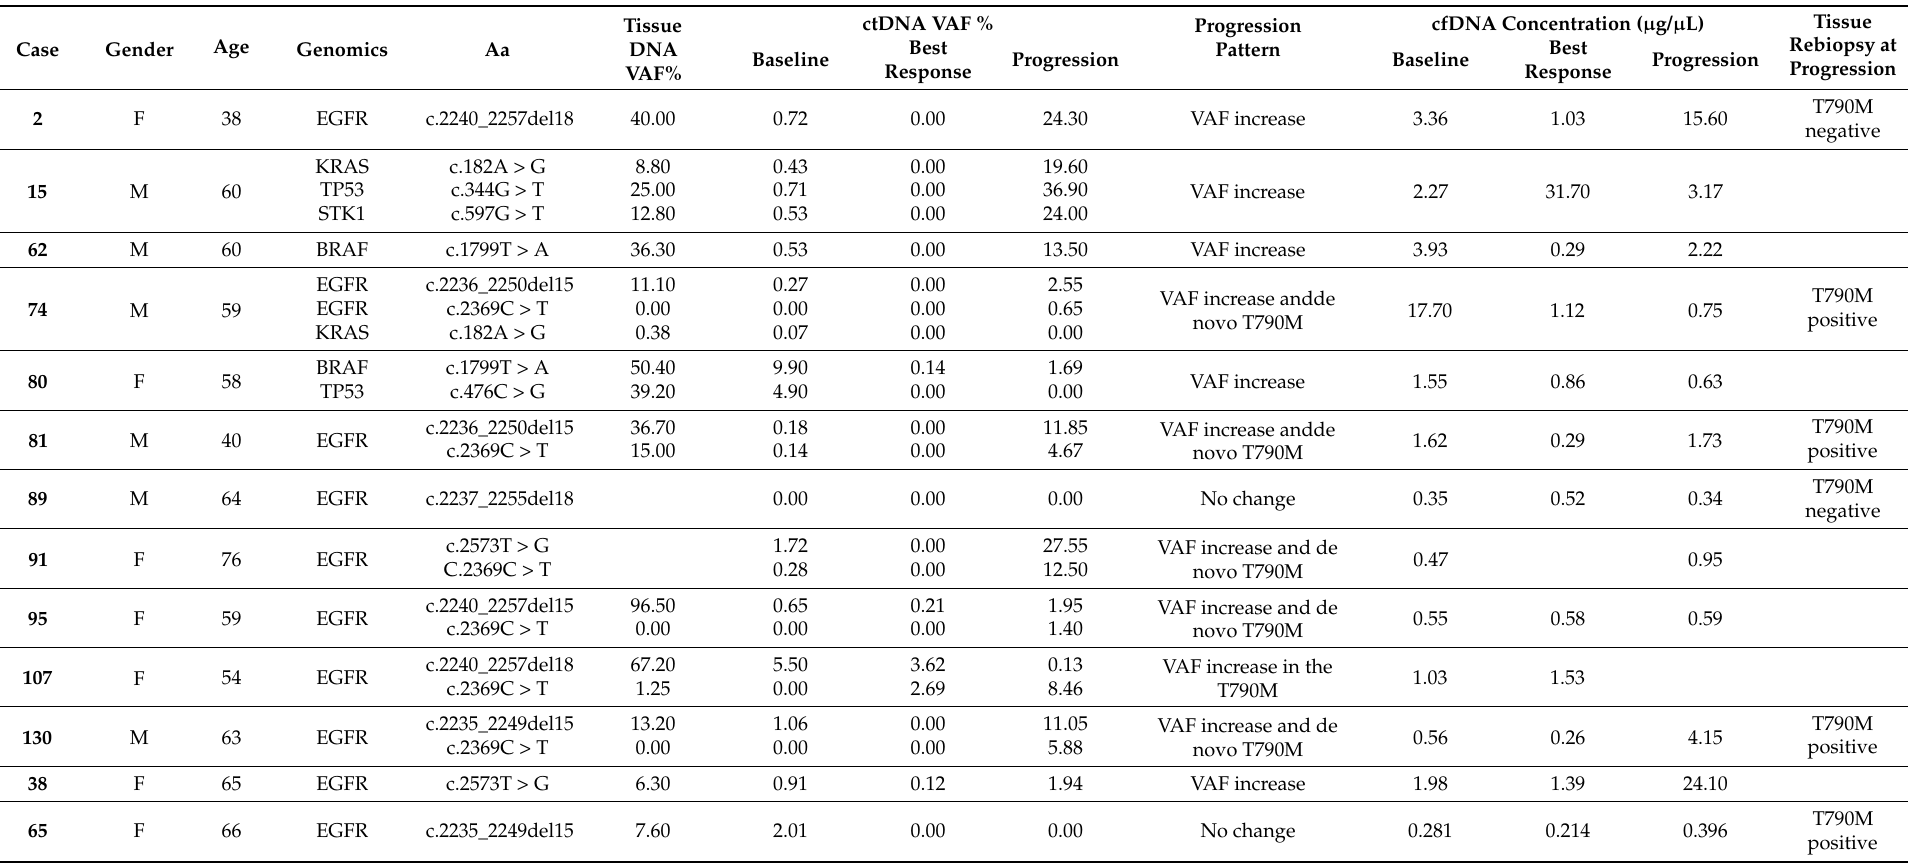
Table 1. Patient (cid:48) s ctDNA NGS sequencing results and progression